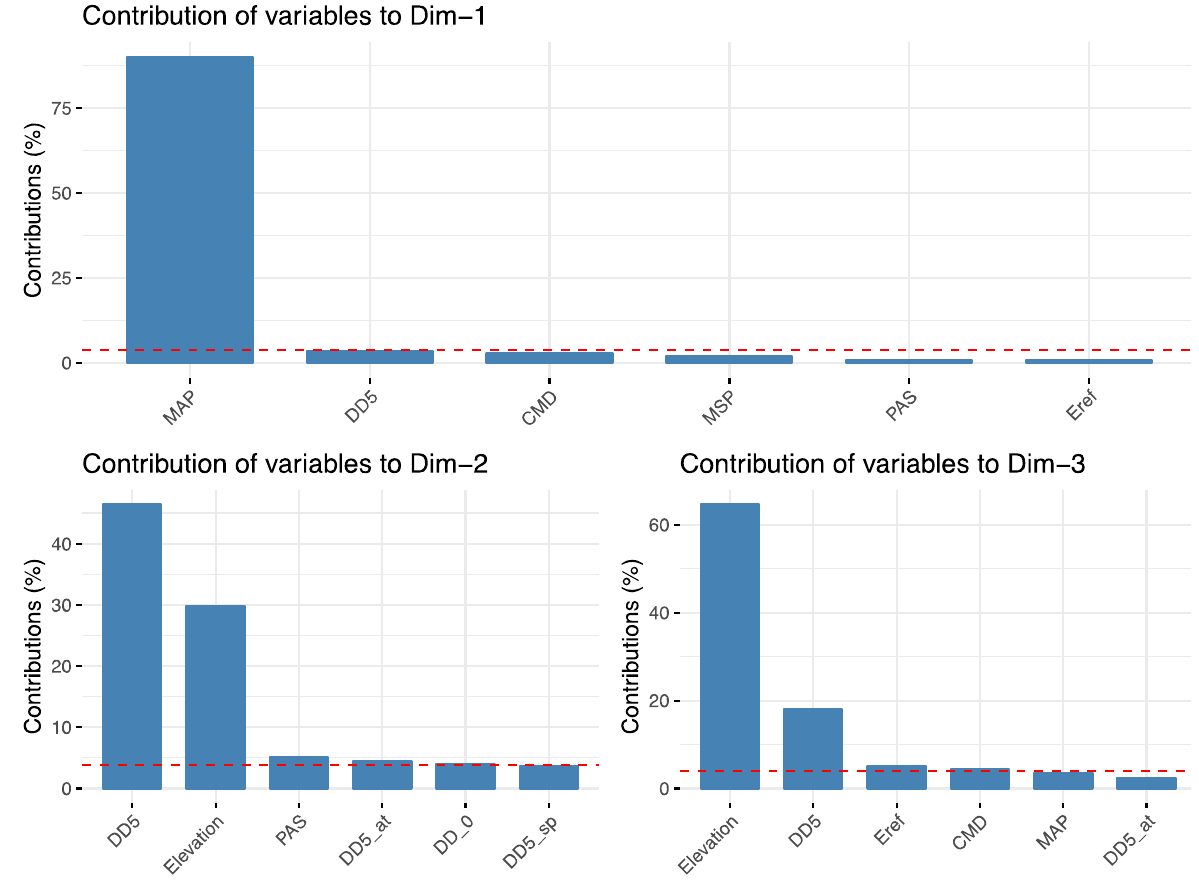
Figure A8. Environmental variables represented by the first two principal components of the PCA of environmental variables. Each pane shows a different principal component. Within each pane, each bar represents the proportion each variable contributes to each axis. The first axis is primarily annual precipitation and winter precipitation. The second axis primarily represents elevation.